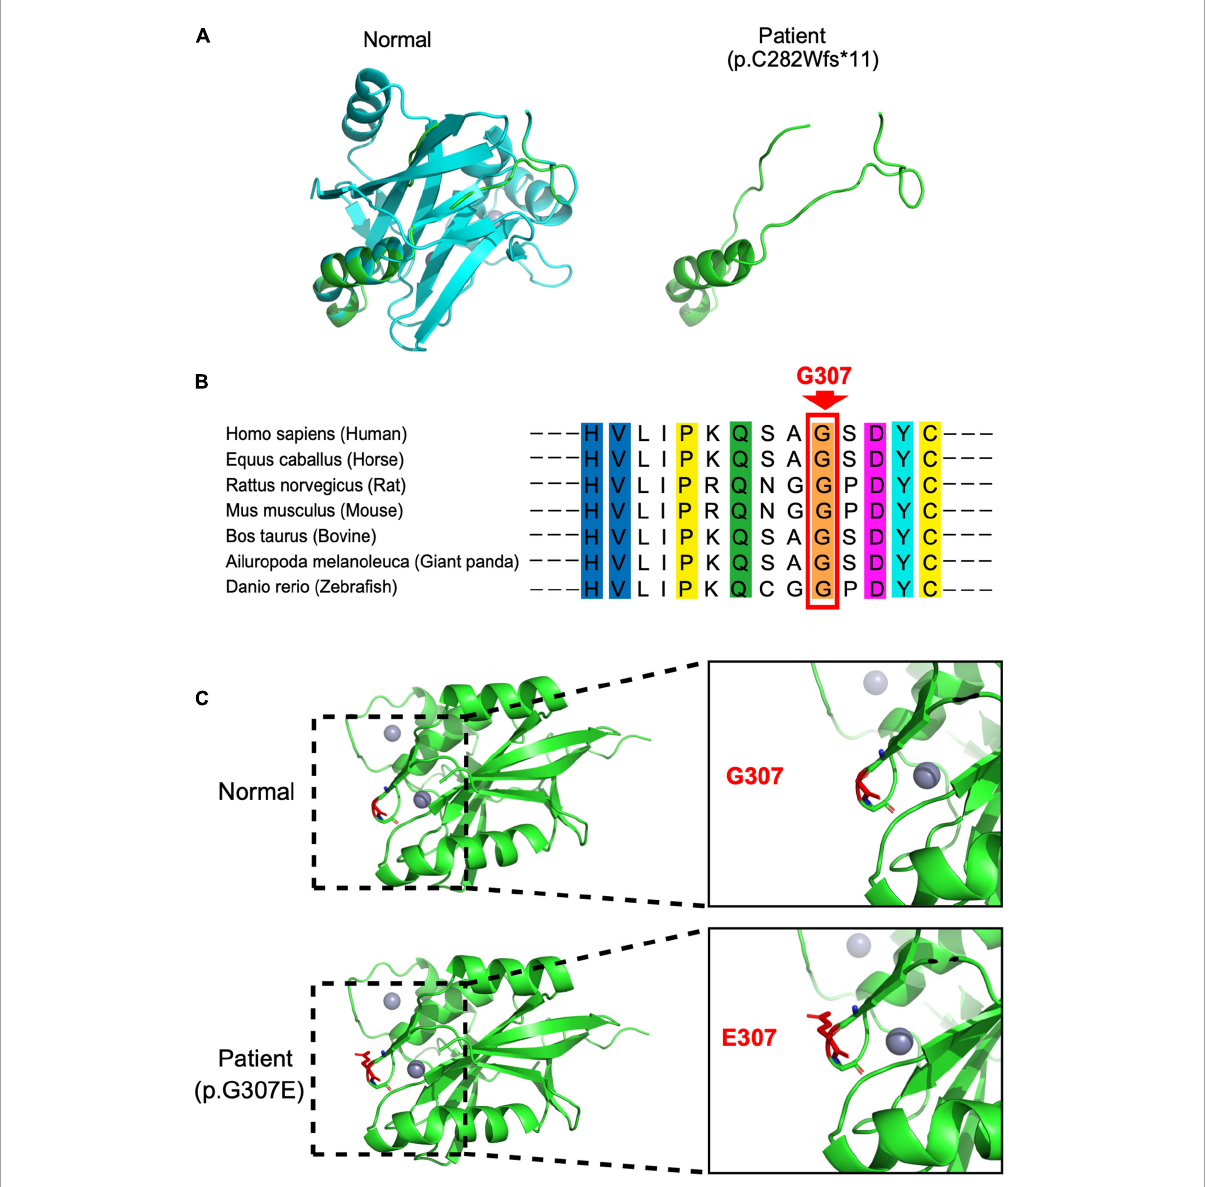
FIGURE2 Protein consequences of STAMBP mutation. (A) Superimposition of the STAMBP (p.C283Wfs*11) protein was achieved using SWISS-MODEL and visualized using PyMOL. The protein structures of STAMBP (left) and STAMBP (p.C283Wfs*11) variation (right). The truncated protein is shown in green. (B) Conservation of mutated residue across evolution. (C) Superimposition of STAMBP (p.G307E) protein was performed using SWISS-MODEL and visualized using PyMOL. Expanded view of patient mutation (p.G307E) showing alternation of the Hydrogen bonds (red dashes) in a loop structure. Also, gray spheres show two bound Zn 2 + atoms. α -helix and β -sheet are shown in